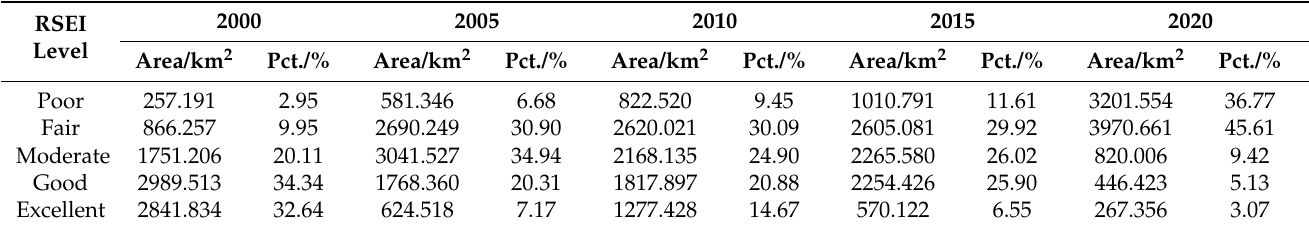
Figure 5. Area distribution of the ecological environment quality levels in the Kuye River Basin in 2000, 2005, 2010, 2015, and 2020. Table 3. Area and percentage of each RSEI level in 2000, 2005, 2010, 2015, and 2020.